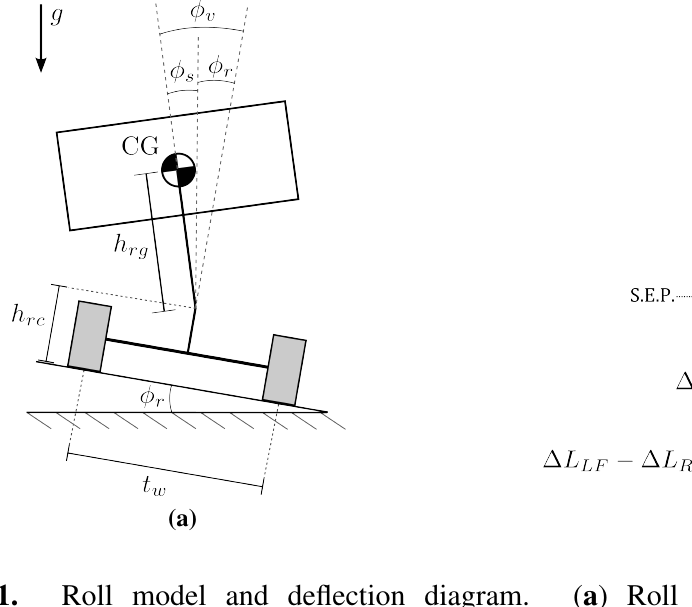
Figure 1. Roll model and deflection diagram. ( a ) Roll model; ( b ) suspension deflection